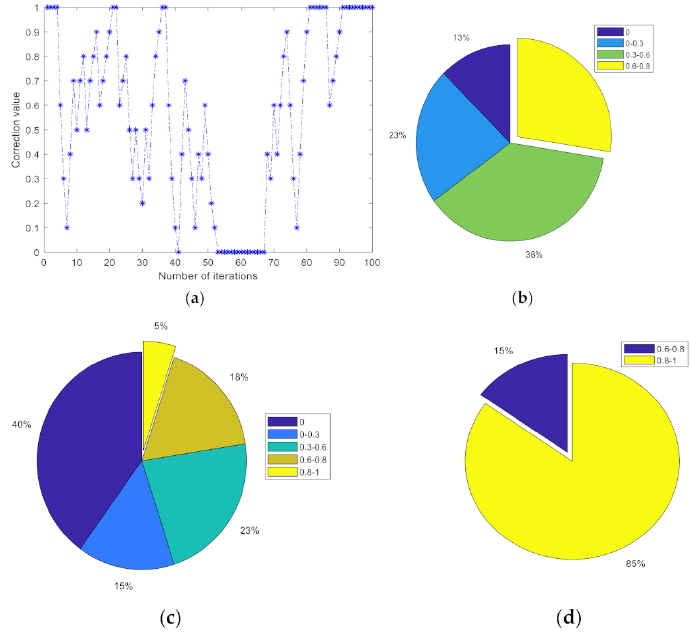
Figure 9. ( a ) The change of recent reputation correction values under different probability of malicious behavior; ( b ) numerical distribution when the probability of malicious behavior is 30%; ( c ) numerical distribution when the probability of malicious behavior is 80%; ( d ) numerical distribution when the probability of malicious behavior is 10%.